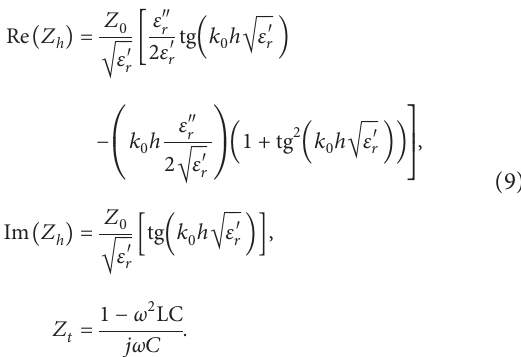
Figure 11: (a) Absorptivity with or without loss of the substrate and (b) absorptivity under different top layer material.